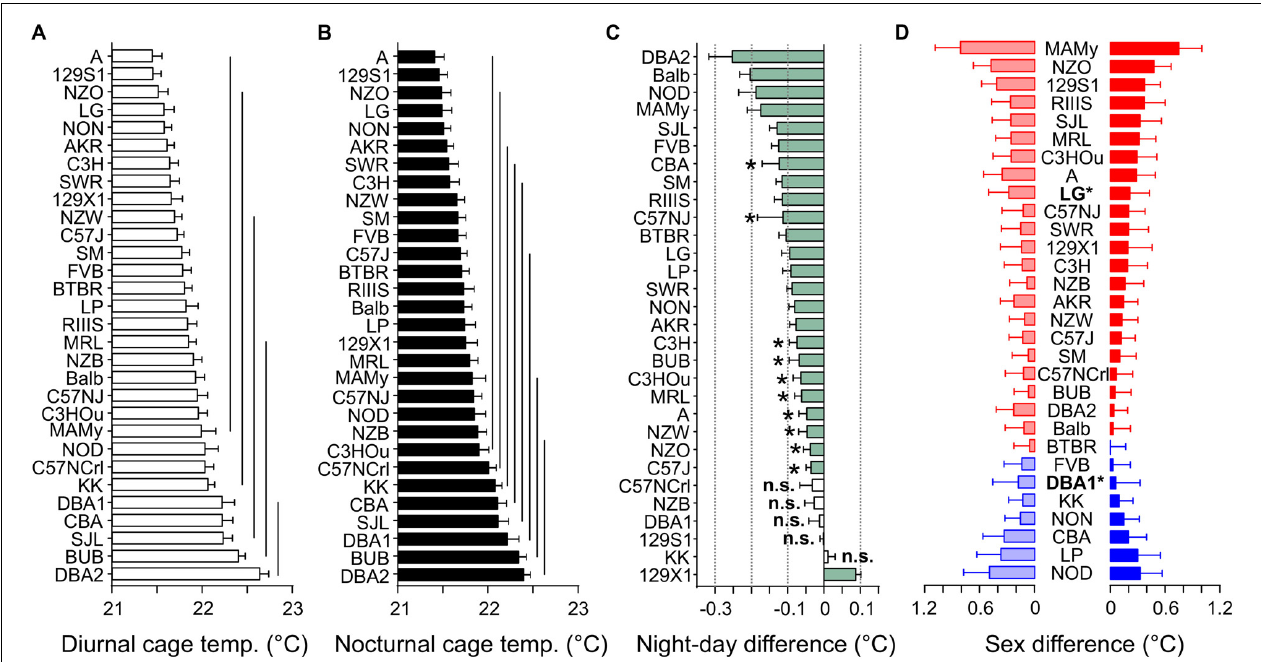
FIGURE 9 | Strain, day–night, and sex differences in cage temperature. Distribution of diurnal (A) and nocturnal (B) cage temperature values ( ◦ C). The values are given as mean values averaged from both sexes with standard errors of the mean and the vertical lines connect groups with homogenous means according to Tukey’s post hoc test. (C) Day–night differences were ranked and Cohen’s D calculated. Significant differences at p < 0.05 are indicated with asterisk and p -levels < 0.001 were not marked; “n.s.” not significant. The effect sizes ranged from D = 0.33 (C57NJ) to D = 1.65 (129X1 and SM). (D) Sex differences were apparent in two strains at p < 0.04. The strains are ranked from largest to smallest sex difference for the scotophase, beginning, at the top, with strains, where females (red) had higher cage temperatures than males, while blue columns illustrate the opposite. To the left, nocturnal values are associated with the respective diurnal values and are displayed in light colors. All values are displayed as means ± standard error of the difference. Asterisks and bold font indicate significant sex differences, * p <